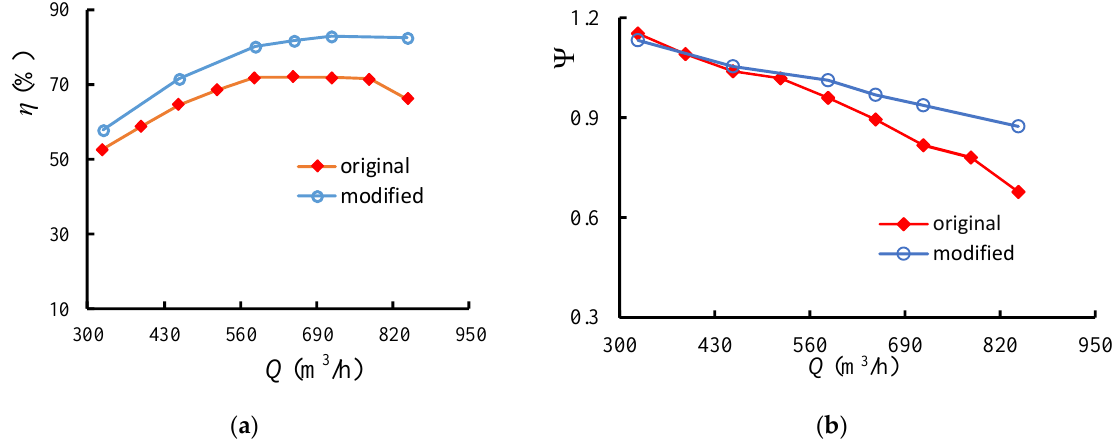
Figure 13. Efficiency and head comparison of the original and modified guide vane structures. ( a ) Efficiency comparison; ( b ) head comparison.